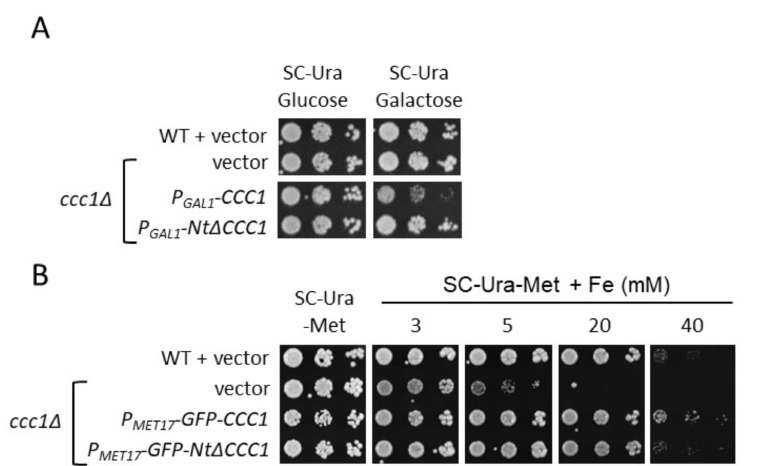
Figure 3. Growth of yeast cells expressing CCC1 with regulatable promoters. ( A ) Expression of CCC1 , but not Nt ∆ CCC1 , with GAL1 promoter is toxic. BY4741 (WT) cells transformed with p416TEF (vector), and ccc1 ∆ cells transformed with p416TEF (vector), p416GAL-CCC1 ( P GAL1 -CCC1 ), and p416GAL-Nt ∆ CCC1 were cultivated overnight in SC-Ura and then spotted on normal SC-Ura (SC- Ura Glucose) and SC-Ura without glucose but with 2% galactose (SC-Ura Galactose). ( B ) Expression of CCC1 with MET17 promoter rescues toxicity. BY4743 (WT) cells were transformed with p416TEF (vector), and ccc1 ∆ cells were transformed with p416TEF (vector), pUG36-CCC1 ( P MET17 -GFP-CCC1 ), and pUG36-Nt ∆ CCC1 ( P MET17 - GFP- Nt ∆ CCC1 ). Cells were cultivated overnight in SC-Ura (which contains methionine) to inhibit CCC1 expression, and then spotted on SC-Ura-Met media with different concentrations of FAS (Fe). Plates were incubated at 30 ◦ C and